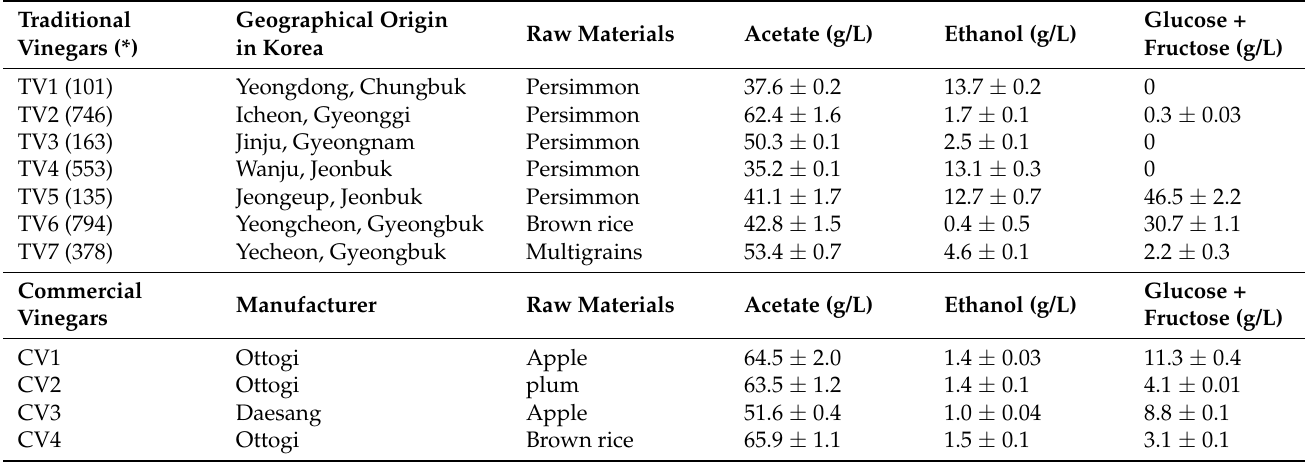
Table 1. Vinegar samples used in this study.